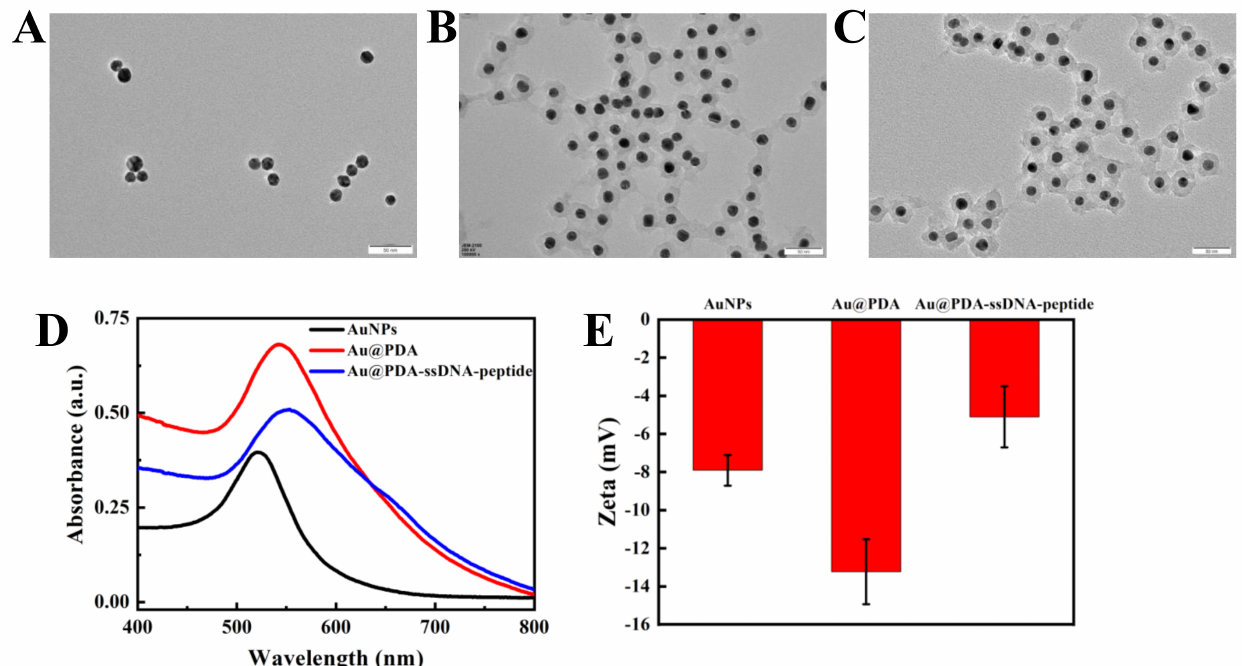
Figure 1. TEM images of AuNPs ( A ), Au@PDA NPs ( B ), and Au@PDA–ssDNA–peptide NPs ( C ). (Scale bar is 50 nm) UV–vis spectra ( D ) and zeta potential characterization ( E ) of AuNPs, Au@PDA NPs, and Au@PDA–ssDNA–peptide